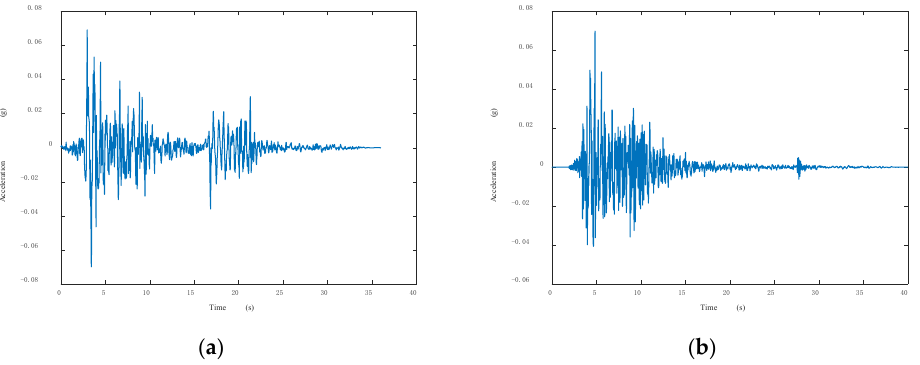
Figure 7. Time history curve of seismic wave acceleration: ( a ) working condition 6; ( b ) working condition 18.